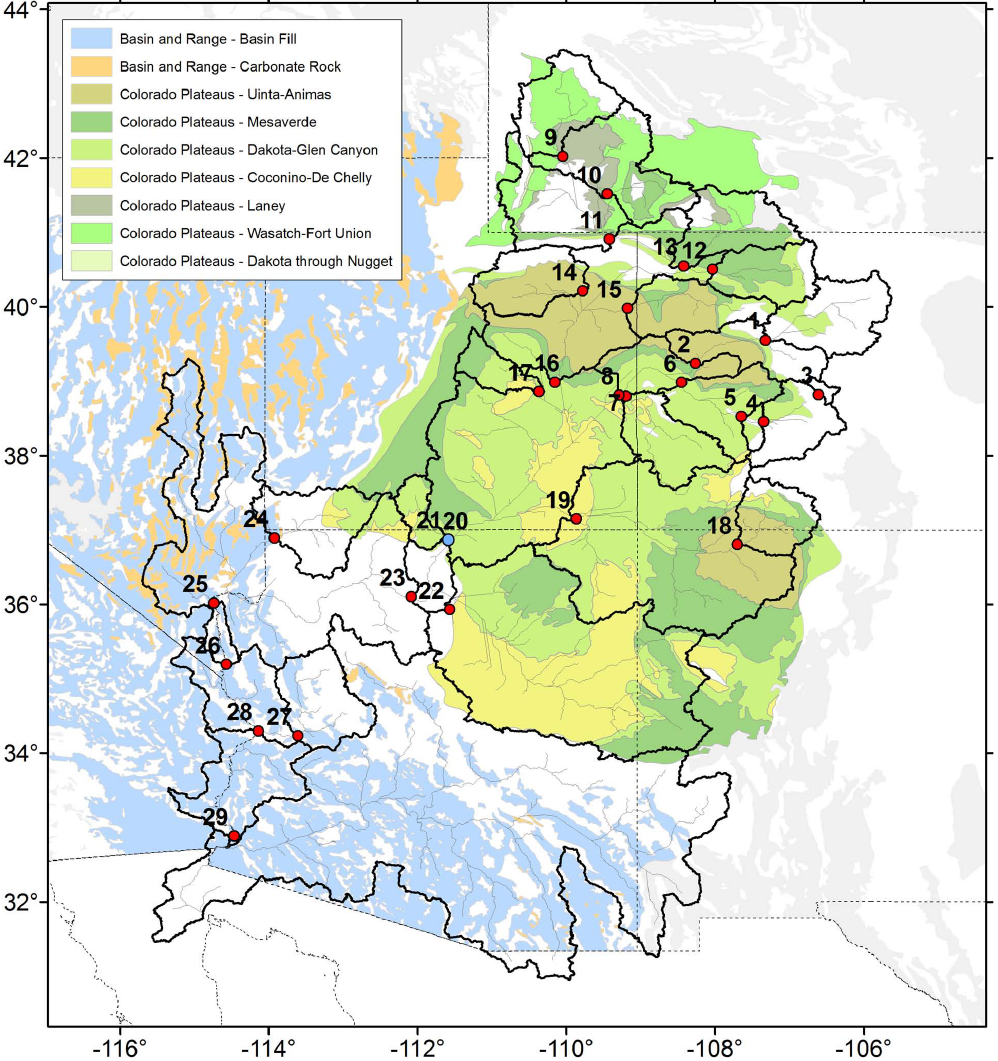
Fig. 1. The Colorado River basin, including the 29 flow locations monitored by USBR, and the uppermost water yielding principal aquifers as given by Miller (1999), Robson and Banta (1995), and Whitehead (1996). Lee’s Ferry (station 20) is indicated in